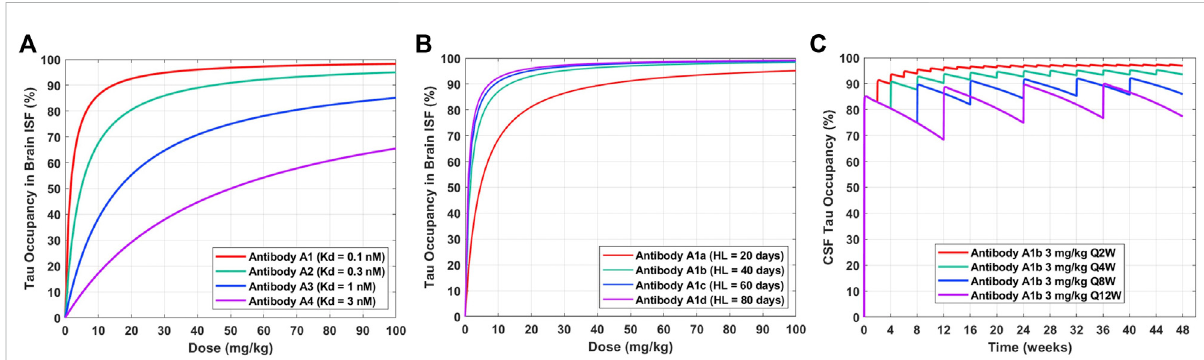
FIGURE 4 Model predictions for the impact of antibody af fi nity, half-life, and dosing frequency on tau dynamics in humans after a single IV dose. (A) Tau occupancyinbrainISFat8weeksasafunctionofdoseforfourtheoreticalantibodies(A1 – A4)withvaryingaf fi nities(0.1 – 3 nM). (B) Tauoccupancyin brain ISF at 8 weeks as a function of dose for four theoretical antibodies (A1a – A1d) with the same af fi nity (Kd = 0.1 nM) and varying elimination half- lives(20 – 80 days). (C) CSF tauoccupancyas afunctionoftime for Antibody A1b(Kd= 0.1 nM,HL=40 days)administeredatadoseof3 mg/kg IV for four different dosing frequencies (Q2W, Q4W, Q8W,